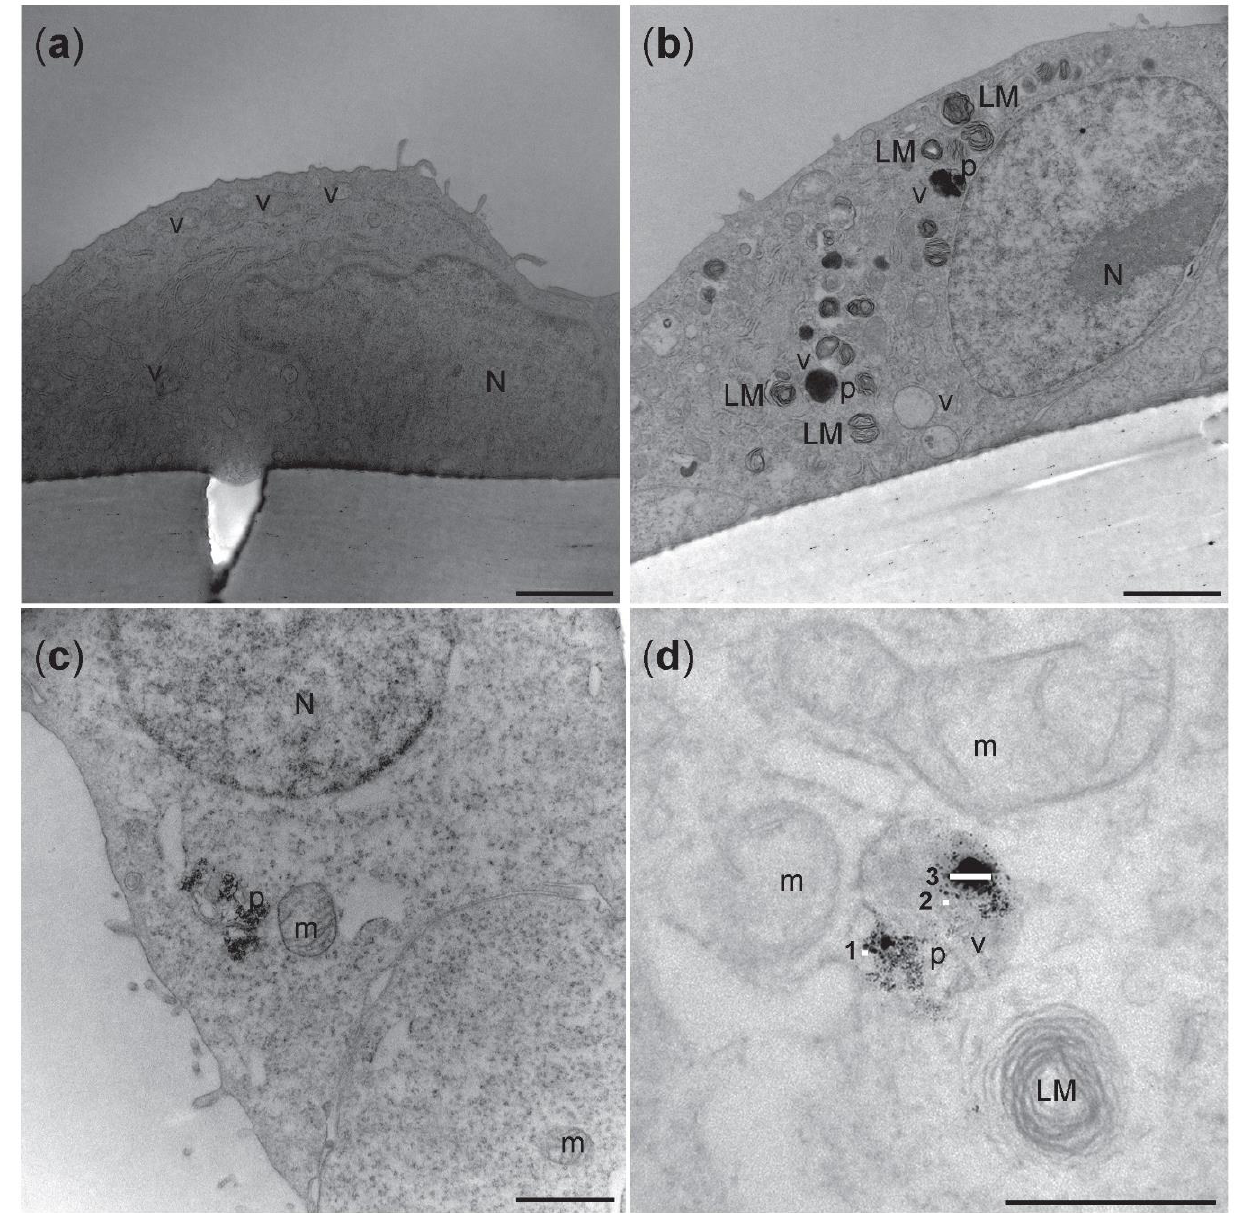
Figure 8. Representative transmission electron micrographs of A549 cells on the apical side of the triculture model. ( a ) Unexposed cells from incubator control (NC) showed no electron dense vacuoles. ( b ) Electron dense vacuoles-like structure and lamellar bodies were seen in cells exposed to NM-300K 10 µ g/cm 2 . ( c , d ) Higher magnification of the cells exposed to NM-300K 10 µ g/cm 2 showed that NM-300K were found in the cell cytoplasm ( c ) or inside of a vacuole ( d ). ( d ) NM-300K were found as single particles (5–20 nm) (1,2) or in small aggregate of 100 nm (3). Scalebar: 2 µ m ( a , b ); 1 µ m ( c ); 500 nm ( d ). N: nucleus, LM: lamellar bodies, v: vacuoles-like structure, p: NM-300K nanoparticles, m: mitochondria.